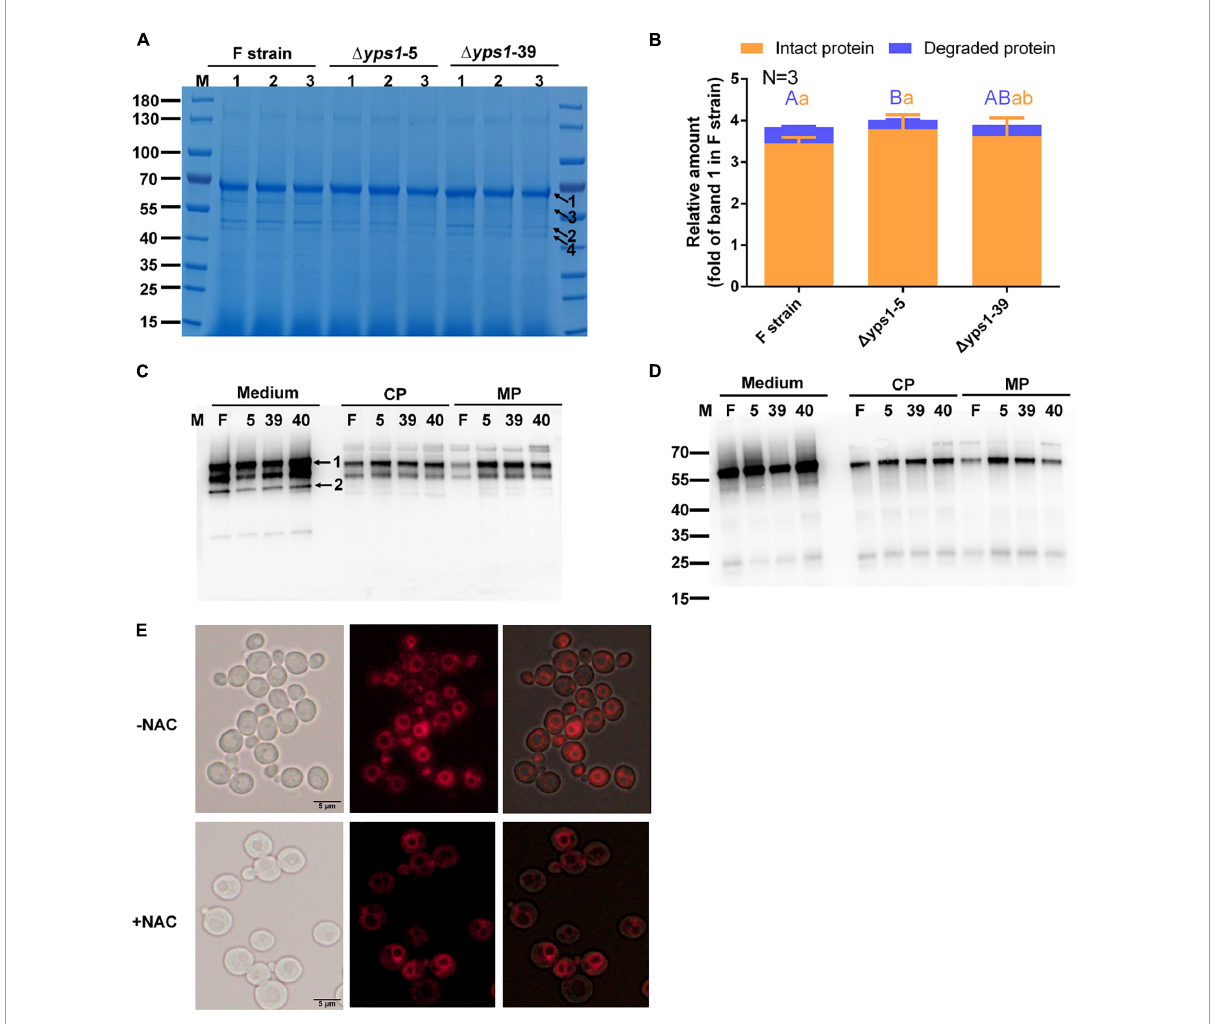
FIGURE4 Effect of N -acetyl-L-cysteine (NAC) on the secretion of intact HSA-pFSH β in (cid:49) yps1 strains. (A) SDS-PAGE analysis of recombinant HSA-pFSH β protein in culture medium treated with 5 mM NAC for 72 h. Numbers 1, 2 and 3 below the horizontal line represent three replicate samples of the same strain. Arrow 1, HSA-pFSH β protein; arrow 2, HSA truncated fragment; arrows 3 and 4, degraded fragments of HSA-pFSH β . (B) The relative amounts of protein bands of figure were estimated using Image J analysis software. The values were normalized to the intact HSA-pFSH β protein band (indicated by arrow 1 in Figure 3A ) in the culture medium of the F strain. Error bars represent means ± standard deviation (SD) ( n = 3). (C,D) Western blot analysis of HSA-pFSH β protein in the culture medium or cells treated with NAC. Blots were probed with antibodies specific reacted with mouse 6 × His tag monoclonal antibody (C) and human FSH β monoclonal antibody (D) . (E) Vacuolar morphology of F strain supplemented with or without 5 mM